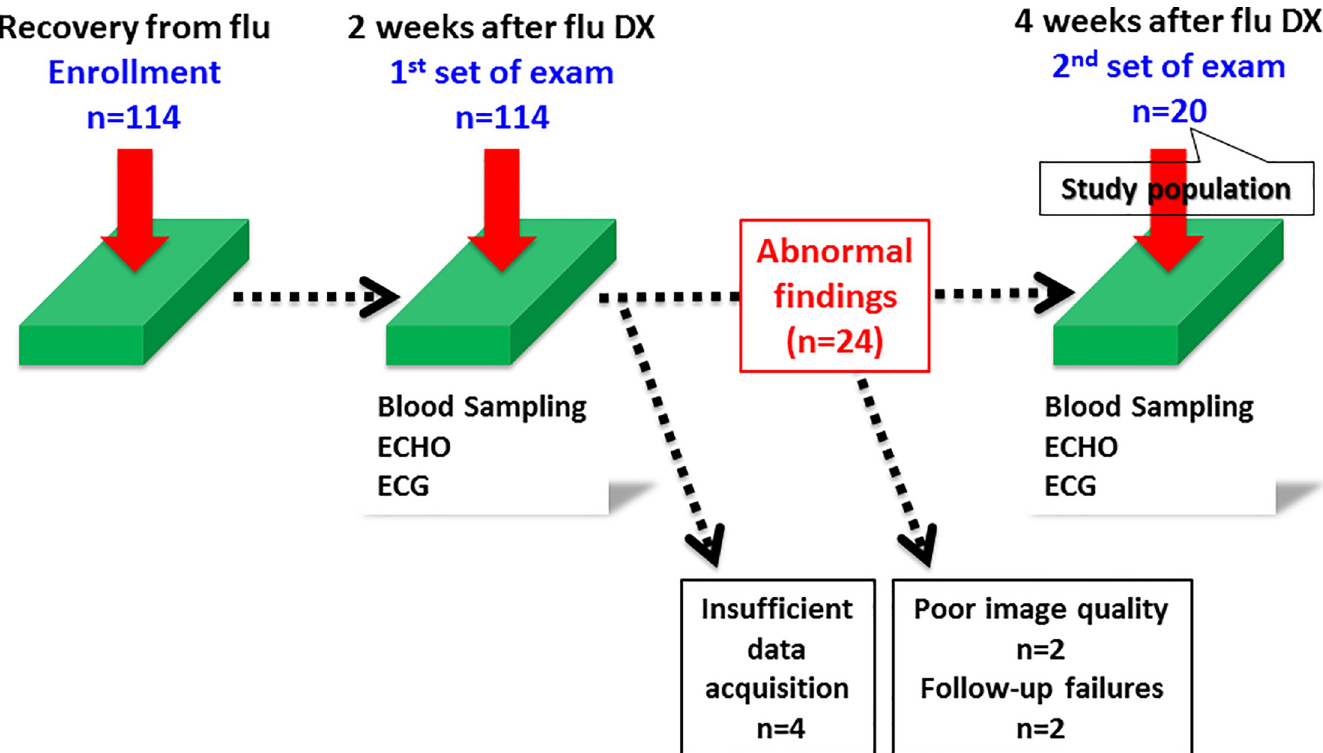
Fig 1. Study protocol and selection of the study